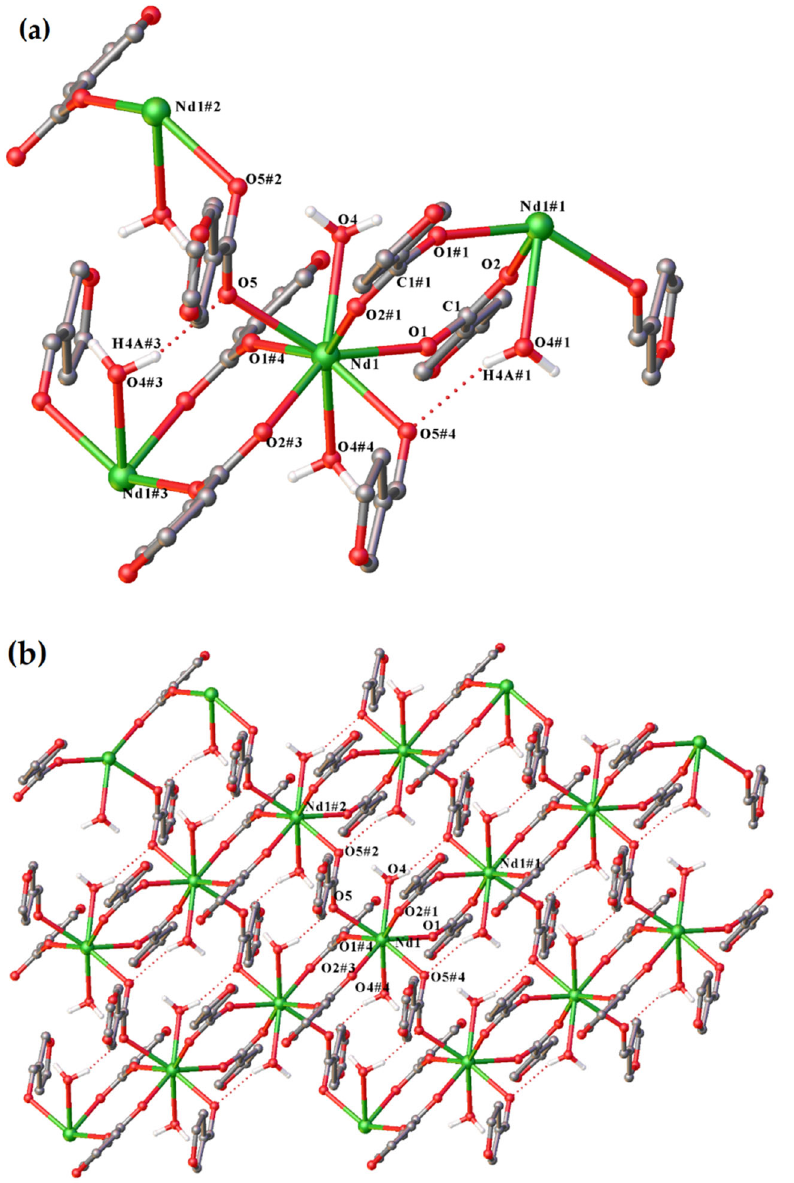
Figure 4. ( a ) The immediate coordination environment around Nd metal atoms in [Nd(3fur) 3 (H 2 O) 2 ]